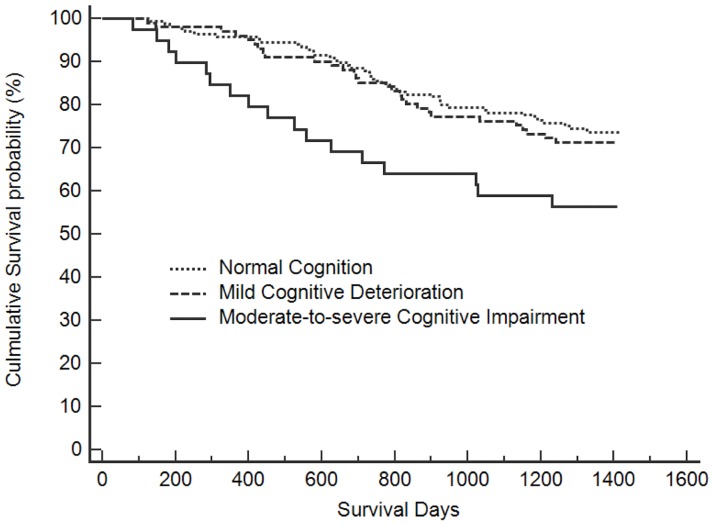
Kaplan-Meier unadjusted survival estimates according to cognitive status.